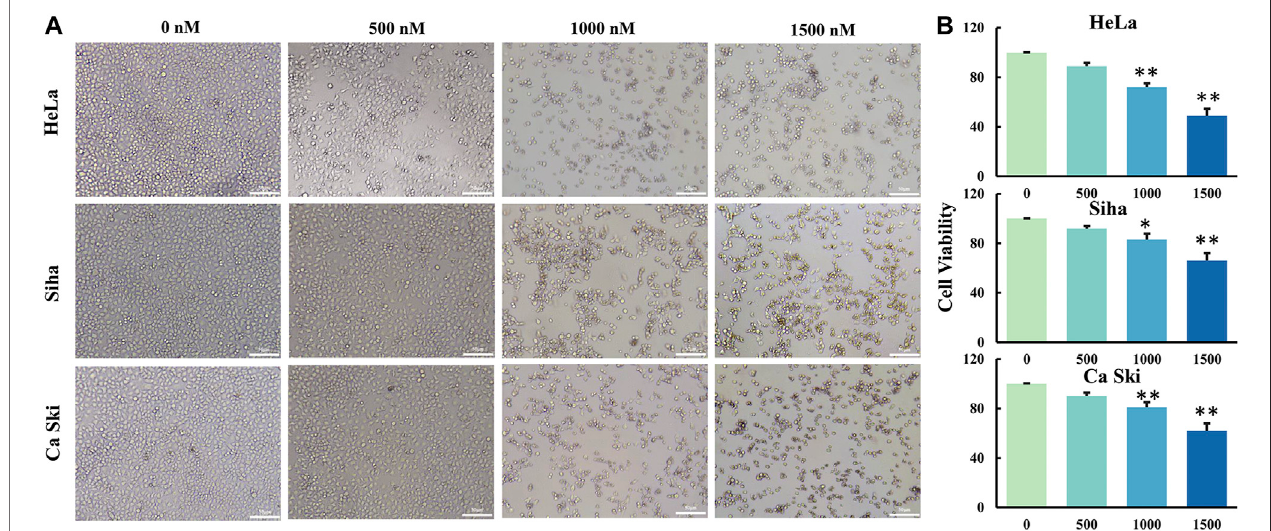
FIGURE 2 | GCP inhibits cell growth of three human cervical cancer cell lines. (A) Hela, Siha and Ca Ski cells were treated with different dose of GCP for 48 h, cell morphology was observed using a microscope (Magni fi cation bars, 50 μ m). (B) The cell viability was detected by CCK8 assay. Each bar represents the mean ± SD of three independent experiments. * p < 0.05, ** p < 0.01 vs